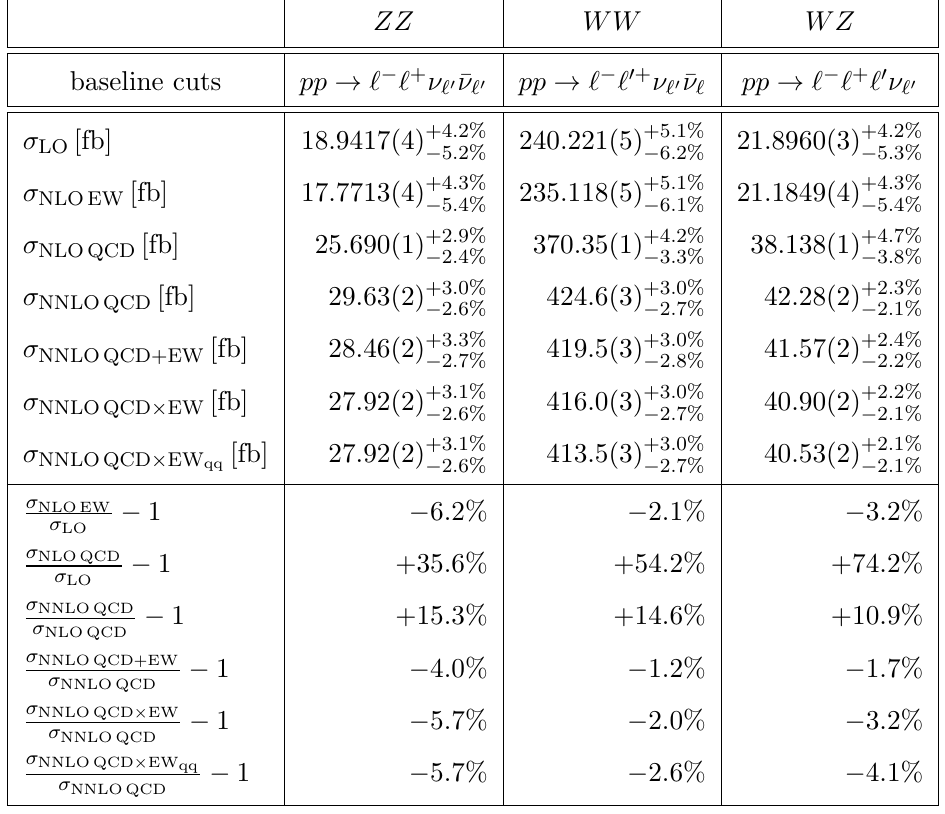
Table 3 . Integrated cross sections for the processes (3.1){(3.3) at p s = 13 TeV. The baseline cuts (3.10){(3.12) are applied without jet veto. The quoted uncertainties correspond to seven-point scale